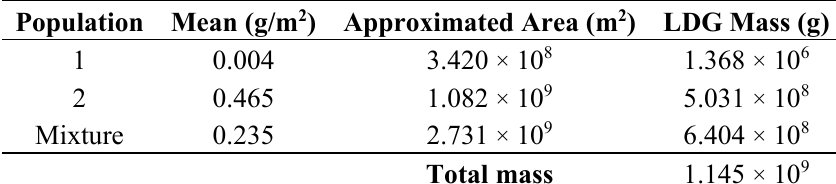
Table 4. Surficial mass of